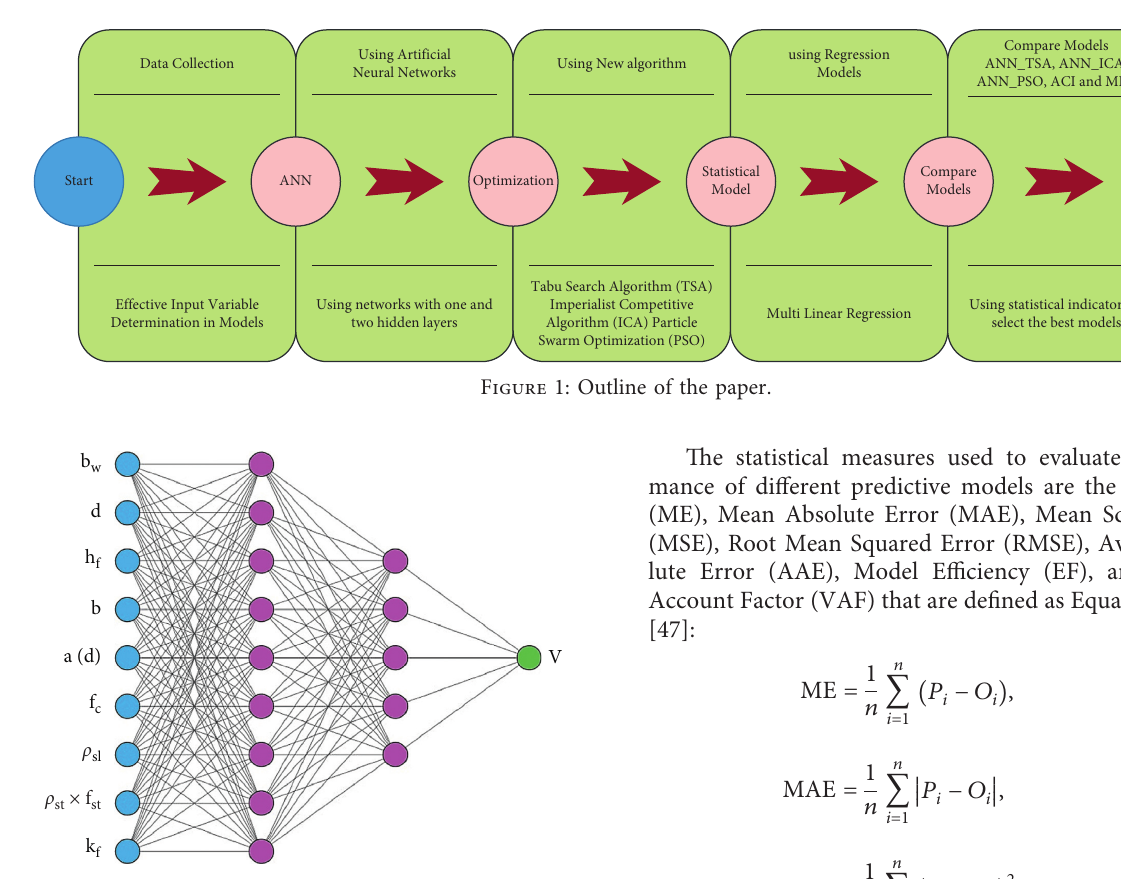
Figure 2: Architecture of the optimum artificial neural network used in this study with 9 input neurons, 16 neurons in the hidden layer, and one neuron in output